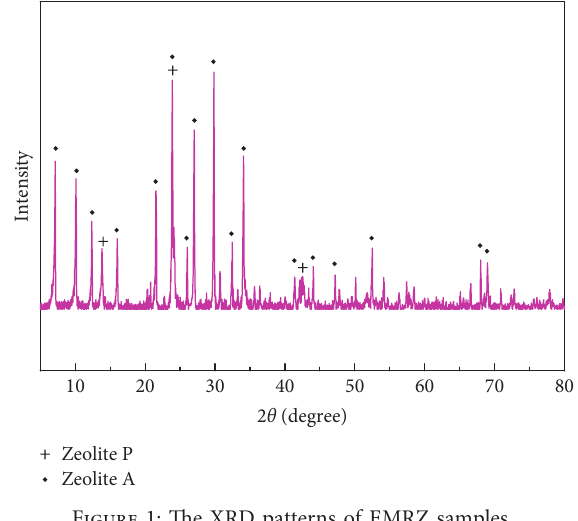
Figure 1: The XRD patterns of EMRZ samples.